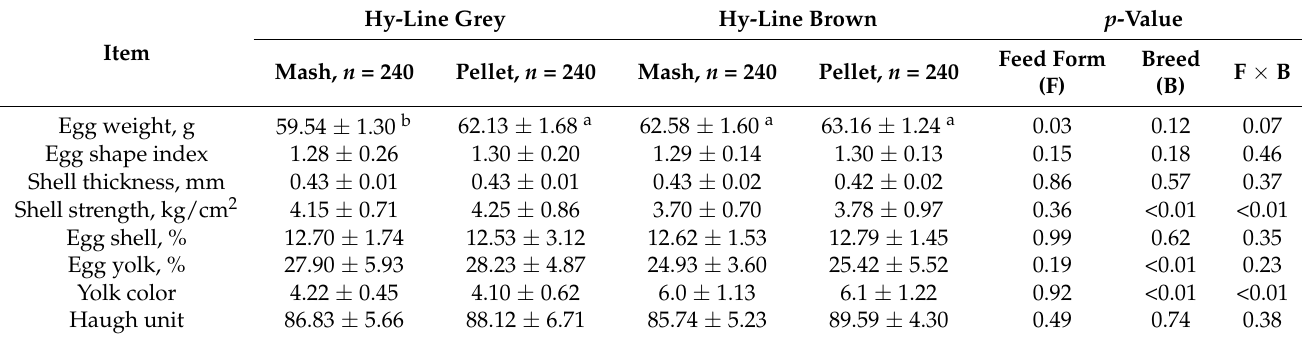
Table 5. Effects of feed form on egg quality traits of layers from 26 to 43 weeks of age.